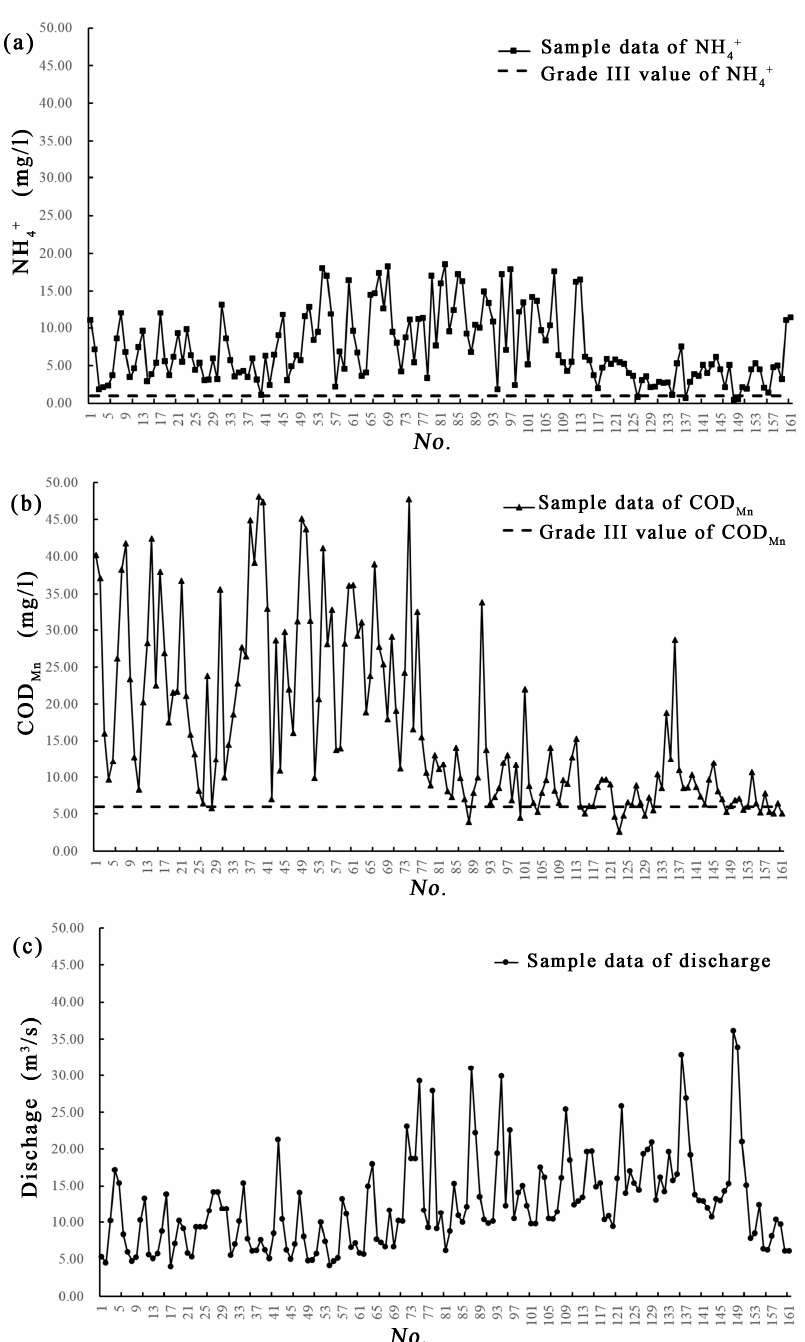
Figure 2. The data series of nitrogen content index (NH 4+ ), permanganate index (COD Mn ), and discharge of the Huangtai Station from 1980 to 2016: ( a ) the sample data and grade III value of NH 4+ ; ( b ) the sample data and grade III value of COD Mn ; and, ( c ) the sample data of discharge.